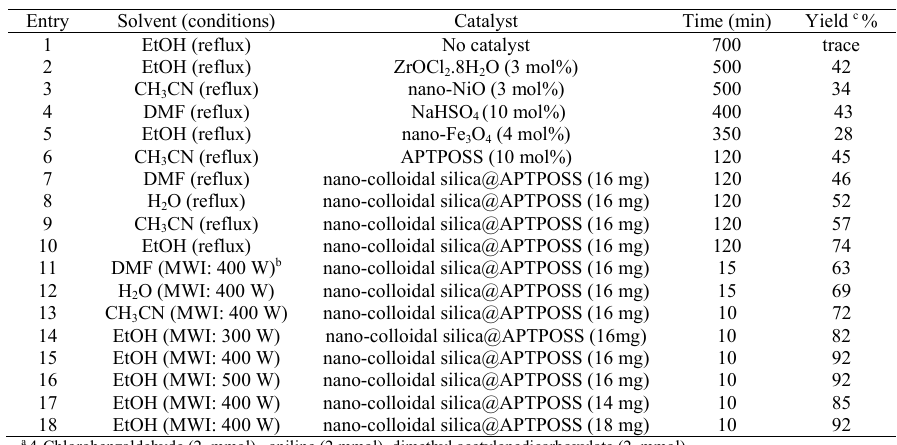
Table 1. Optimization of the reaction conditions using different catalysts under different conditions a